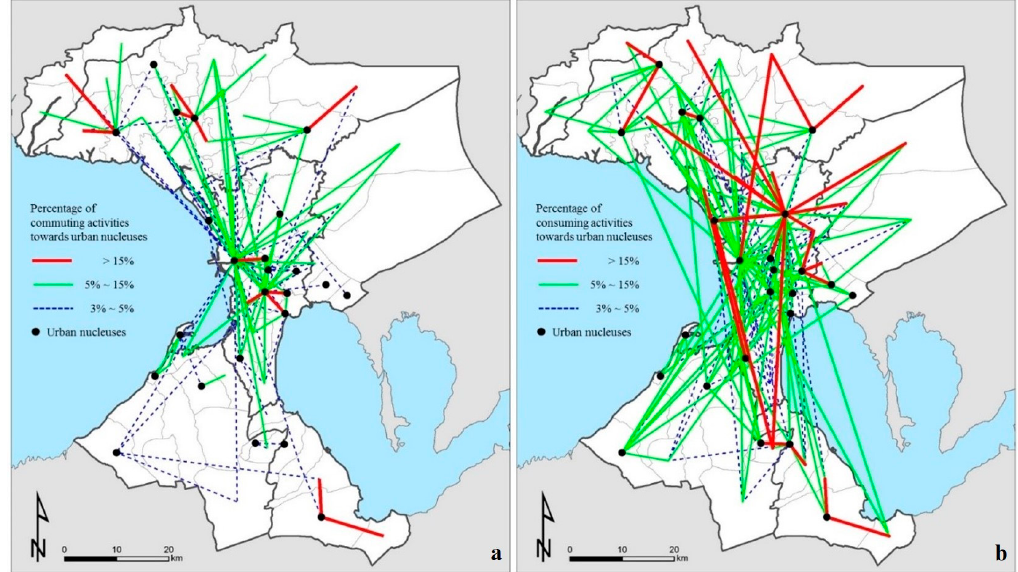
Figure 6. Spatial pattern of connection and influence among commuting nucleuses ( a ) and among consuming ones ( b ).